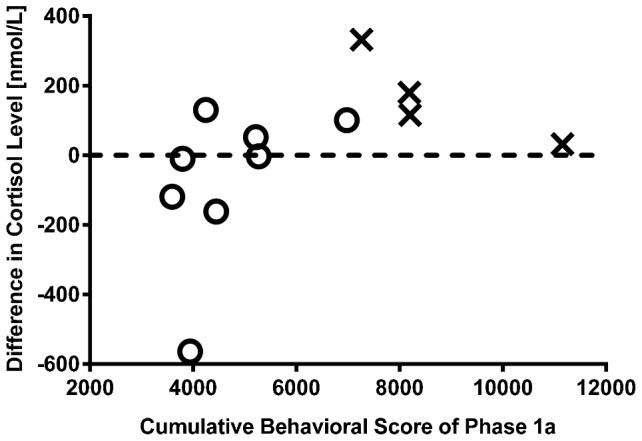
Differences in plasma cortisol concentration and cumulative behavioral scores during Phase 1a used to select animals for Phase 1b.Cumulative behavioral scores over the Phase 1a training obtained from all animals (n = 12), in which animals with lower behavioral scores (n = 8, ‘O’) were selected to transition into the Phase 1b study and ones with higher scores were deselected (n = 4, ‘×’). In addition, to assess the stress level during the awake training, plasma cortisol concentrations were measured from these animals at two separate time points (∼ one month apart) during this phase, and results indicated that the reduction in cortical level is likely associated with better habituation (i.e. lower behavioral scores).